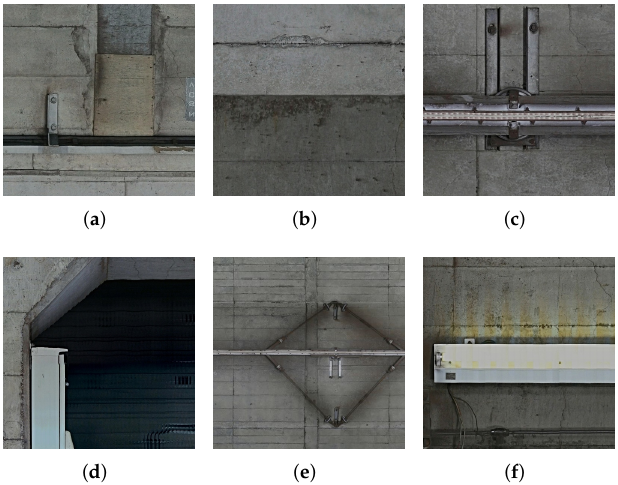
Figure 3. Example of background images. ( a – f ) show cable, concrete joint, connection component of overhead conductor rail, passage tunnels, overhead conductor rail, and lighter, respectively. (Resolution: 1 mm/pixel, Image size: 256 × 256